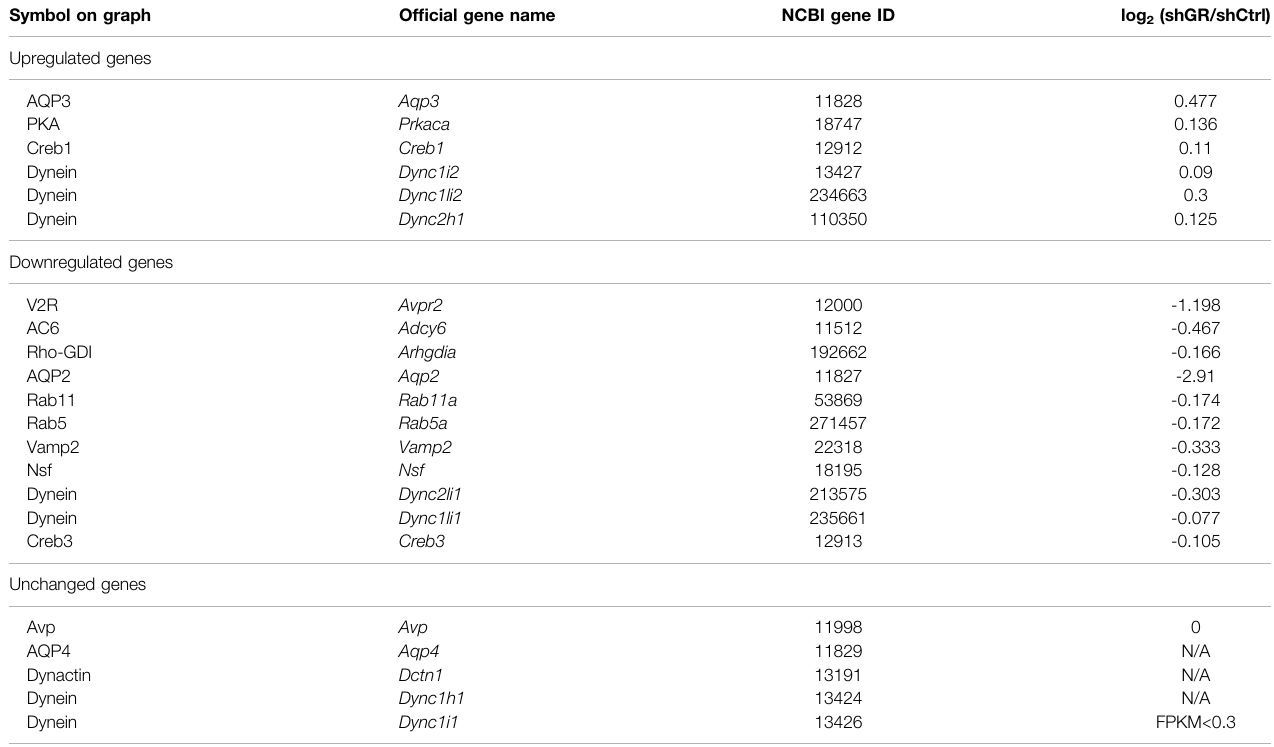
TABLE 5 | “ Vasopressin-regulated water reabsorption pathway ” gene table. Symbol on